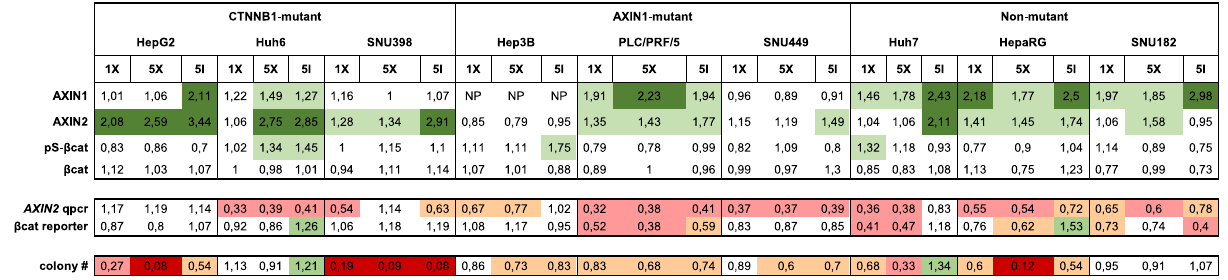
Table 1. Summary of western blot, β-catenin signaling and colony formation analyses. Fold changes relative to controls for each analysis are depicted and color-coded. Significant increases are shown in green colors, while decreases are shown in orange/red colors. 1X is 1 μM XAV939; 5X is 5 μM XAV939; 5I is 5 μM